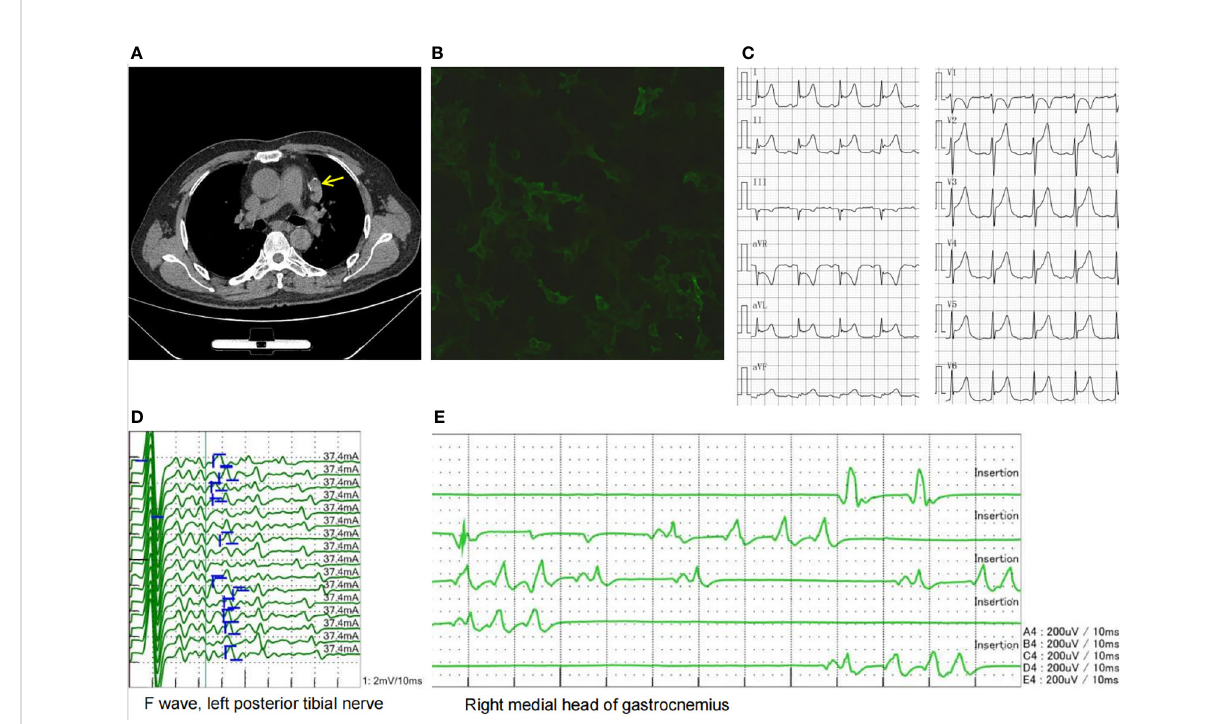
FIGURE 2 (A) Chest CT showing a thymic mass in the left anterior mediastinum (yellow arrow). (B) LGI1 antibody cell-based assay showing a 1:32 positive ratio. (C) ECG showing acute anterior, lateral, and high lateral myocardial infarction-like ECG changes. (D) Afterdischarges were observed in the F wave. (E) Needle EMG showing duplet, triplet, and multiplet bursts of spontaneous motor unit discharges in the tested muscles of the limbs at rest suggestive of myokymia. CT, computed tomography; LGI1, leucine-rich glioma-inactivated 1; ECG, electrocardiogram; EMG,